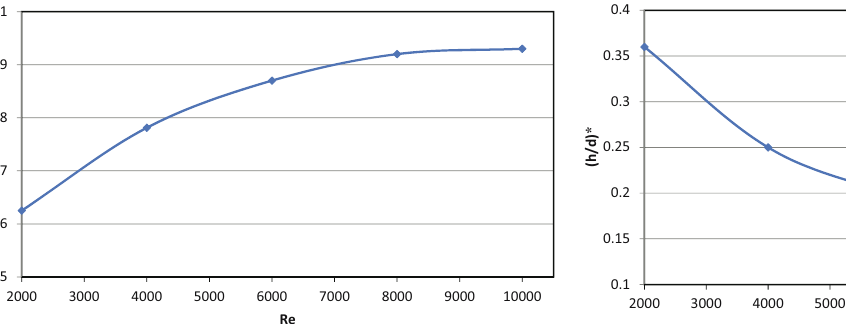
Figure 10: The changes in optimal dimensionless pitch ( p/d ) * versus Reynolds number.